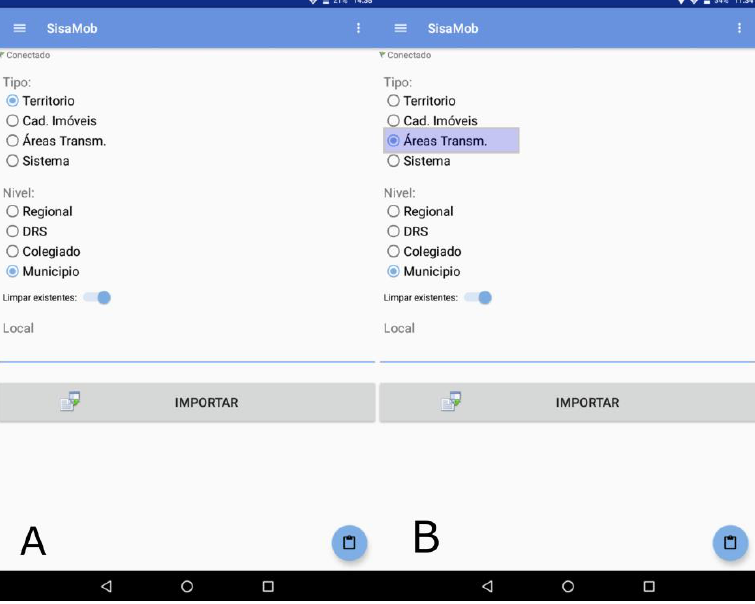
Figure 3 . ( A ) APP configuration by hierarchic management level for the implementation of tabular and graphic database of the APP; ( B ) Highlighted the option of transmission areas—it allows the download of the so-called risk areas for implementation of control activities. Note: Tipo = Type; Território = Region; Cad. Imóveis = Property Registration; Áreas Trans. = Transmission Areas; Nível = Level; Regional = Administrative Region; DRS = Administrative Regional Health Board; Colegiado = Collegiate (Set of regional leaders of the state with equal powers); Município = Municipality.